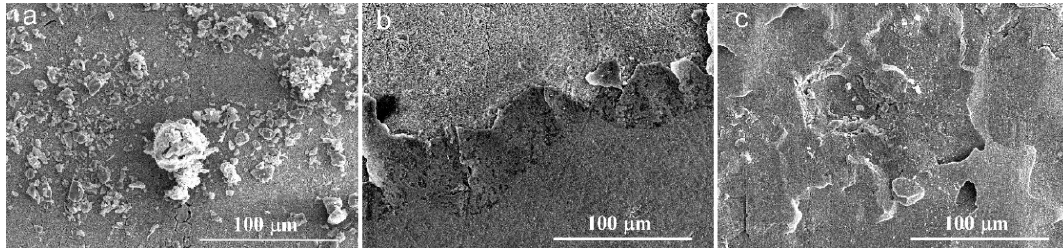
Figure 10. Morphologies of the corroded regions after the anodic polarisation. ( a ) The bare alloy; ( b ) The alloy with preoxidation procedure 1; ( c ) The alloy with preoxidation procedure 2.